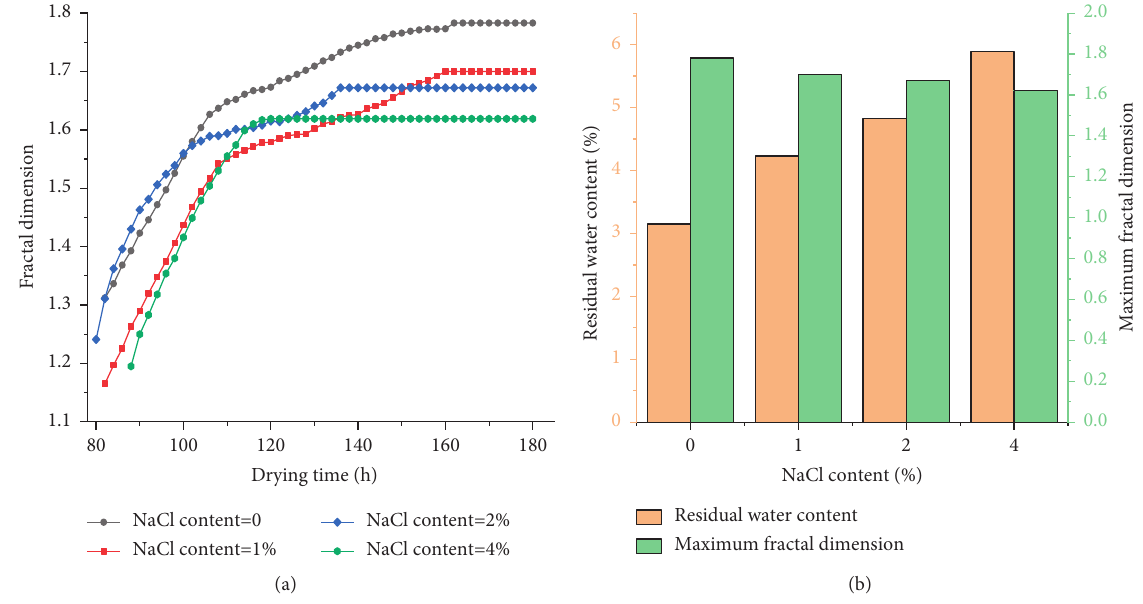
Figure 5: Fractal dimension with different NaCl concentrations. (a) Fractal dimension with time. (b) Residual water content and maximum fractal dimension versus NaCl concentration.